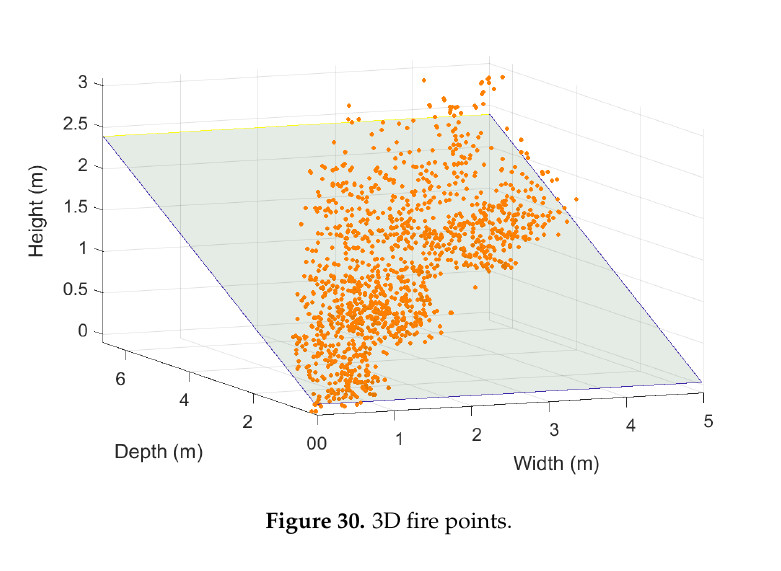
Figure 30. 3D fire points.